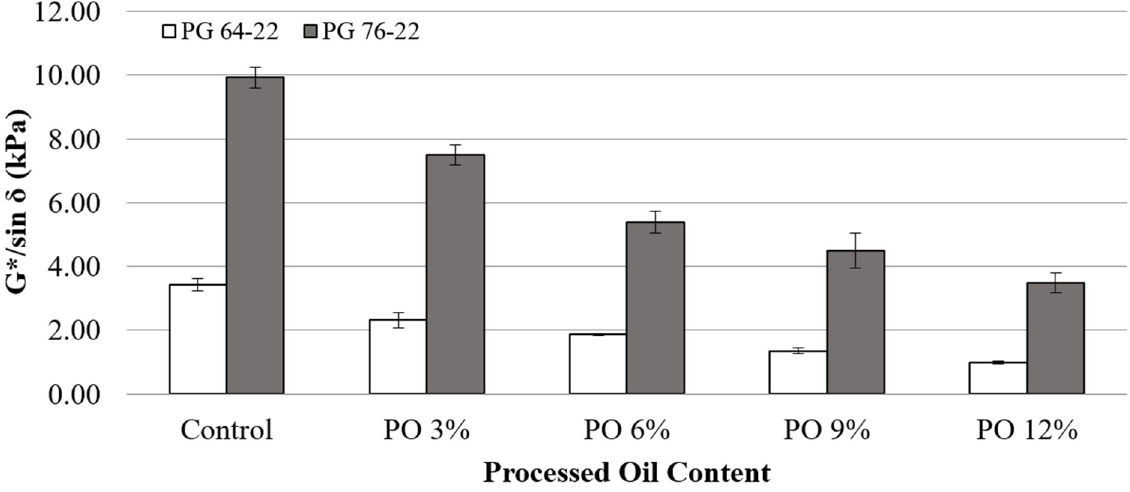
Figure 6. G*/sin δ of the RTFO asphalt binders with processed oil at 64 °C. Table 6. Statistical analysis results of the G*/sin δ of RTFO test as a function of processed oil content ( = 0.05).